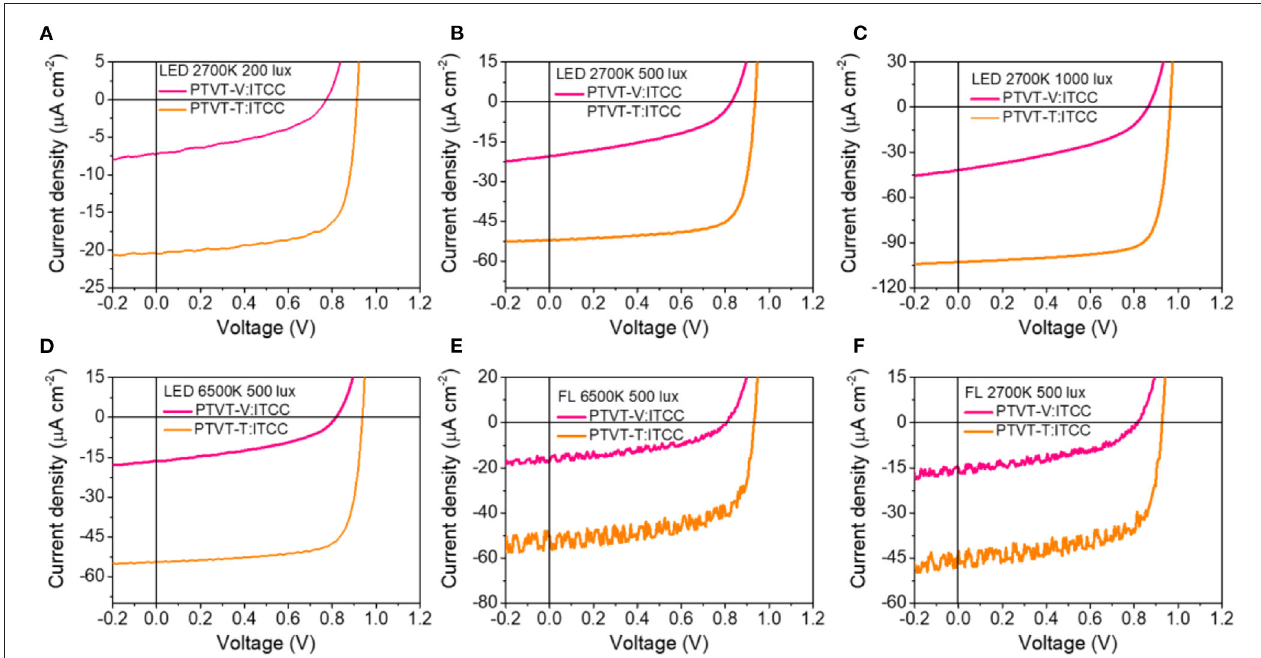
FIGURE 3 | J-V curves of the devices based on PTVT-V:ITCC and PTVT-T:ITCC under various light sources with different light intensities of (A) LED 2,700K, 200 lux. (B) LED 2,700K, 500 lux. (C) LED 2,700K, 1,000 lux. (D) LED 6,500K, 500 lux. (E) FL 6,500K, 500 lux. (F) FL 2,700K, 500 lux.